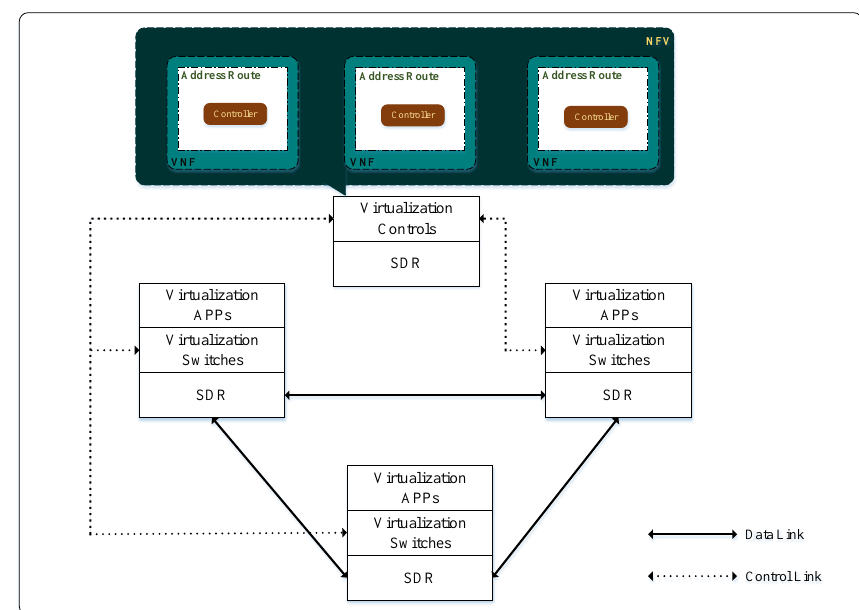
Figure 5. Routing implementation of control forwarding separation.